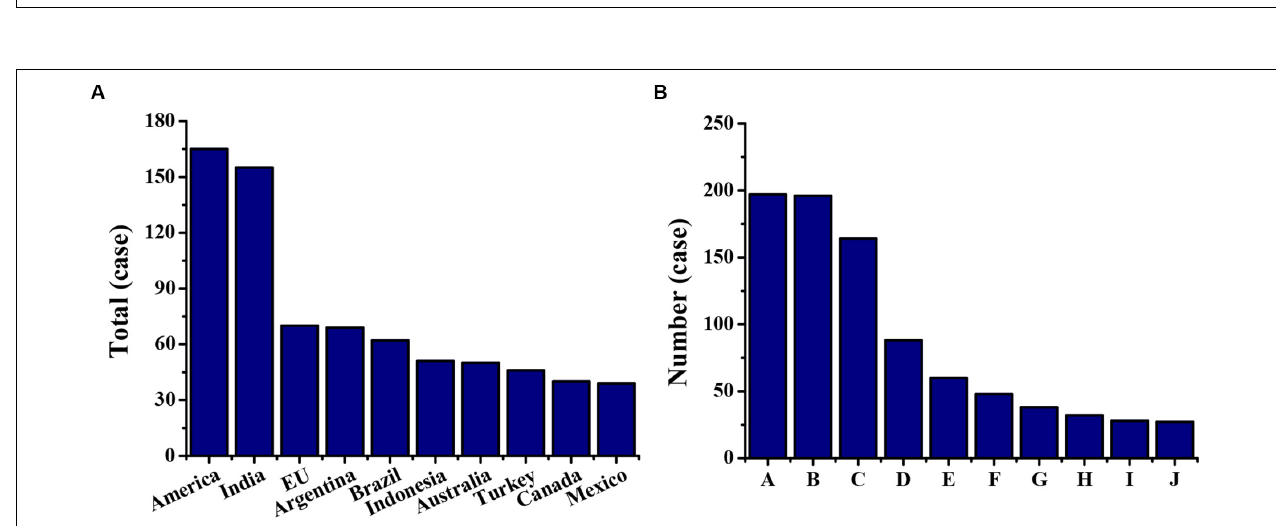
FIGURE 4 | Proportions of the number of the global and China-related trade frictions from 2009 to 2019 [Figure (A) is the proportion of the global trade frictions; Figure (B) is the proportion of China-related trade frictions].